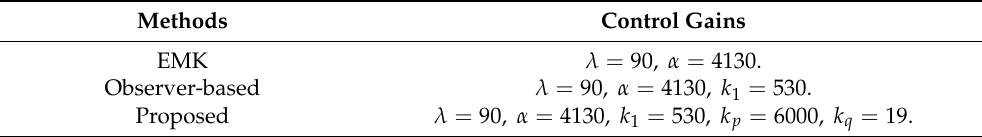
Table 1. The control parameters of the three controllers.